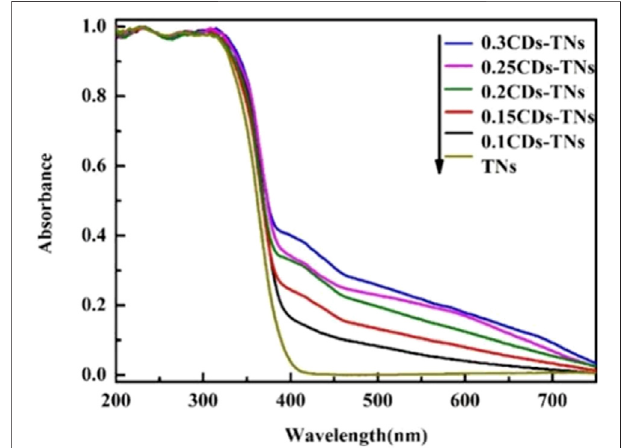
FIGURE 2 | UV-vis DRS spectra of TNs and CD-TNs with different CDs